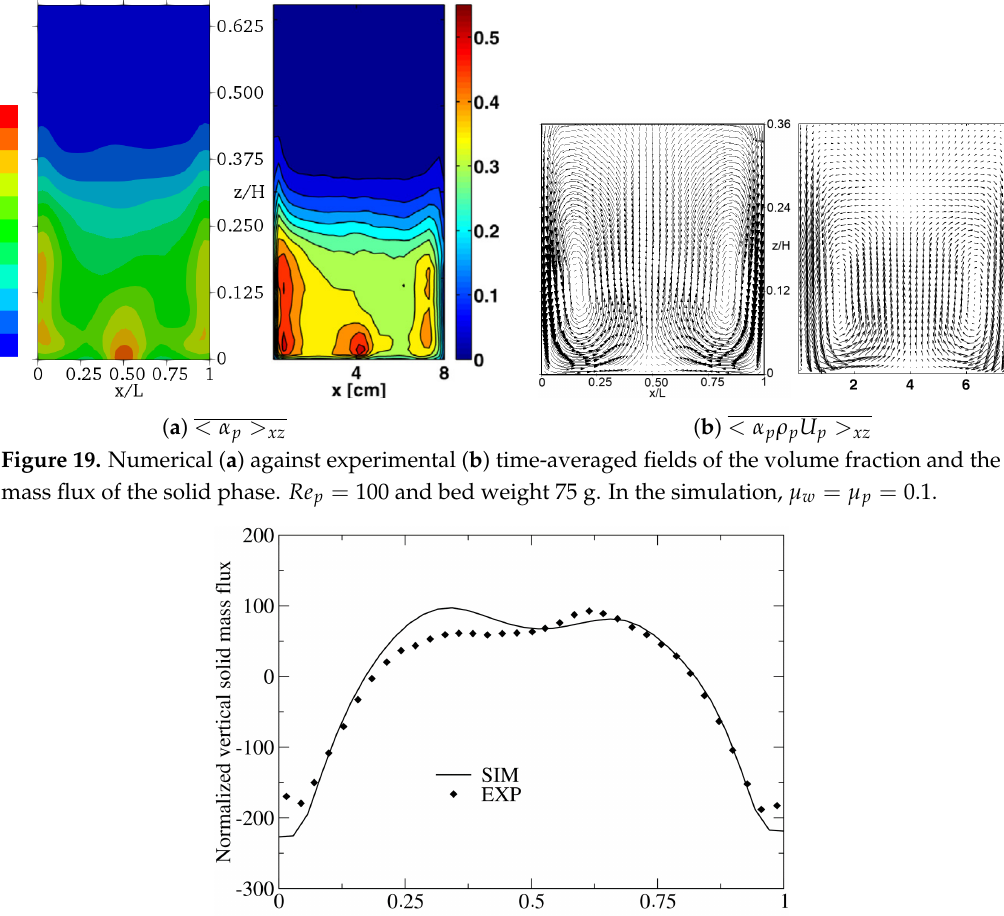
Figure 20. Numerical against experimental time-averaged vertical mass flux, < α p ρ p U p the solid at the height z / H = 0.092 above the bottom of the bed. Re p = 100 and bed weight 75 g. In the simulation, µ w = µ p =